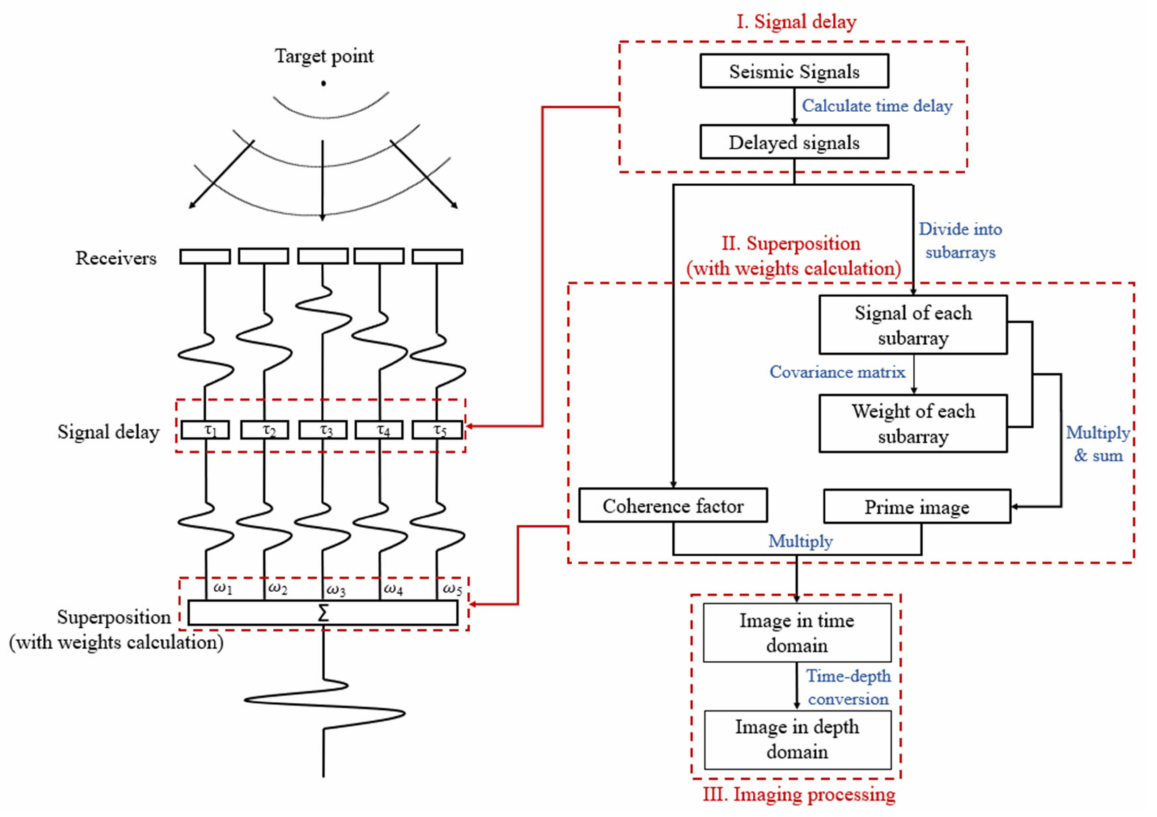
Figure 1. Workflow of MVSS beamforming